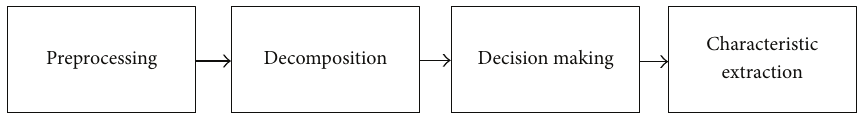
Figure 9: General workflow of an “automatic sleep spindle detection method” (ASDM). It is composed of 4 modules: preprocessing, decomposition, decision making, and characteristic extraction. The latter is